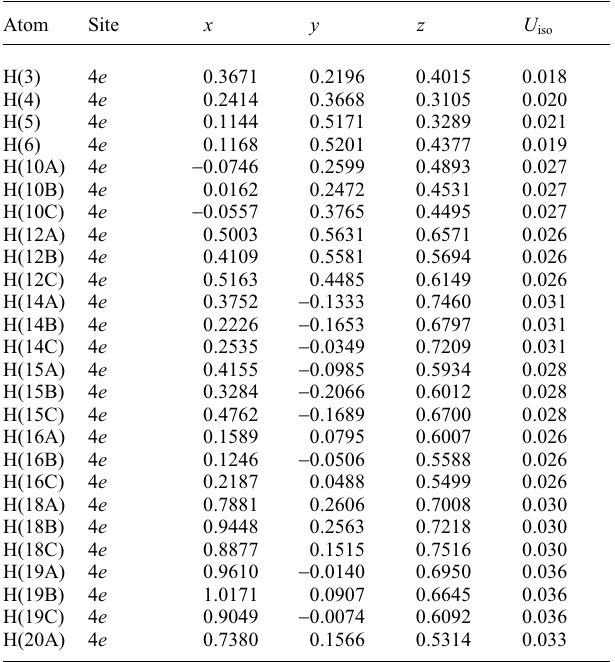
Table 2. Atomic coordinates and displacement parameters (in Å 2 )